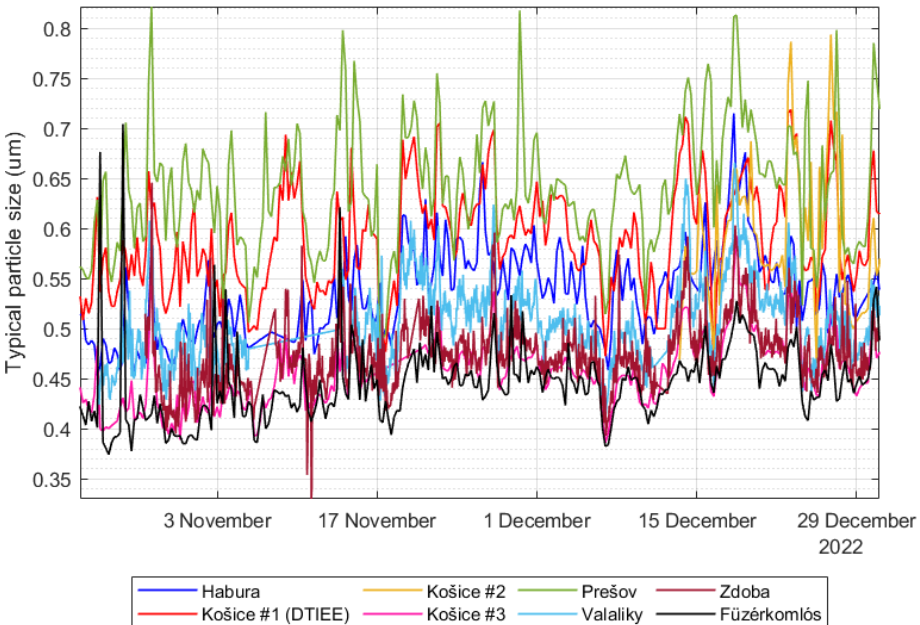
Figure 10. Changes in typical particle size in different locations: Habura, Košice #1 (DTIEE), Košice #2, Košice #3, Prešov, Valaliky, Zdoba, Füzérkomlós from 2 October 2022 to 31 December 2022. More detailed information (including the interquartile range, minimum, maximum, median, and outliers in data points) about the measuring sites is presented in Figure 11 using the box plot. The values of the interquartile range, minimum, maximum, and me- dian are summarized in Table 3.